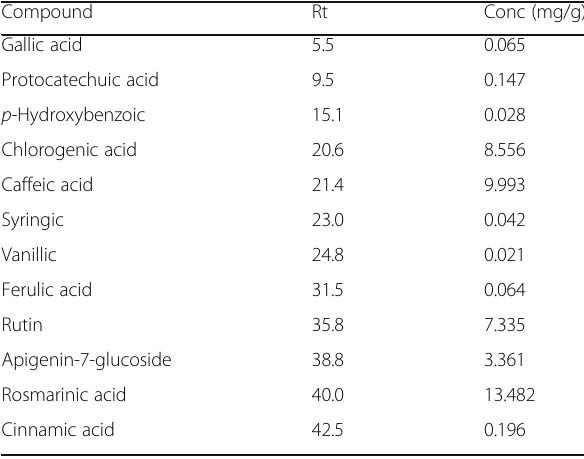
Table 6 HPLC profile of total ethanol extract of Thevetia peruviana